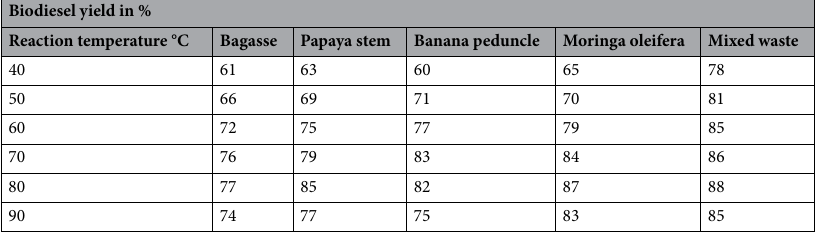
Biodiesel yield in